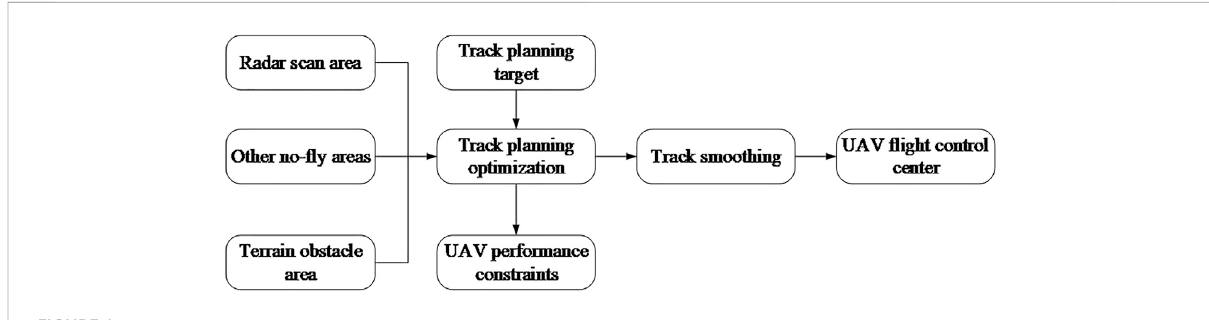
FIGURE 1 Flow chart of the trajectory planning